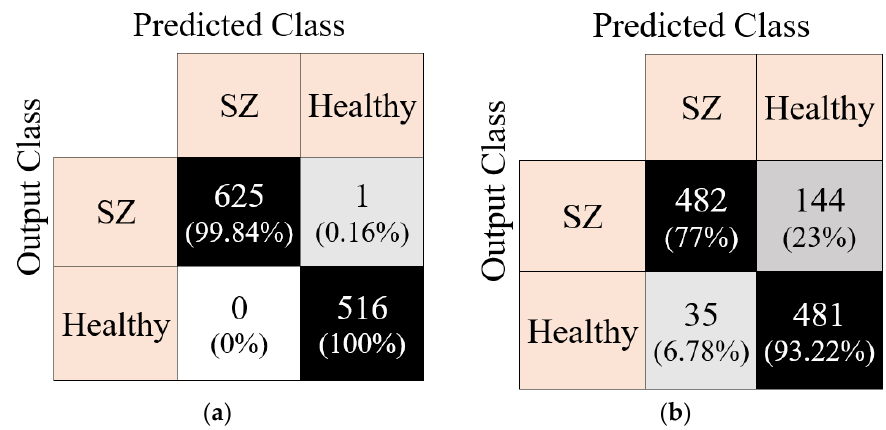
Figure 7. Voted results: confusion matrices of the presented CGP17Pat-based EEG classification model using ( a ) 10-fold cross-validation and ( b ) LOSO cross-validation.